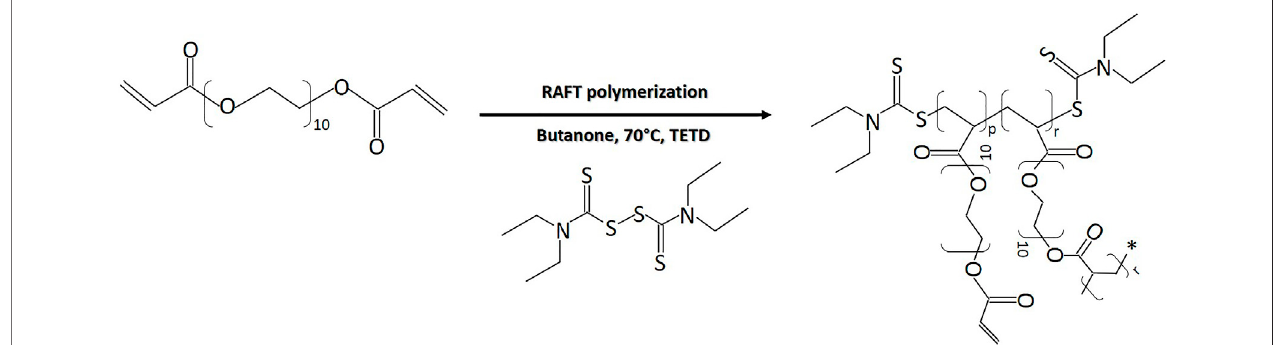
FIGURE 1 | RAFT polymerization reaction of PEG-diacrylate for HB PEGDA synthesis ( p (cid:2) 0.45) ( r (cid:2)